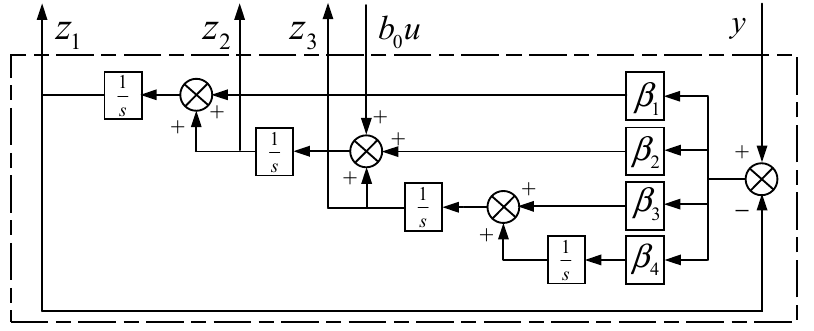
Figure 6. Structure diagram of the new linear extended state observer (LESO).